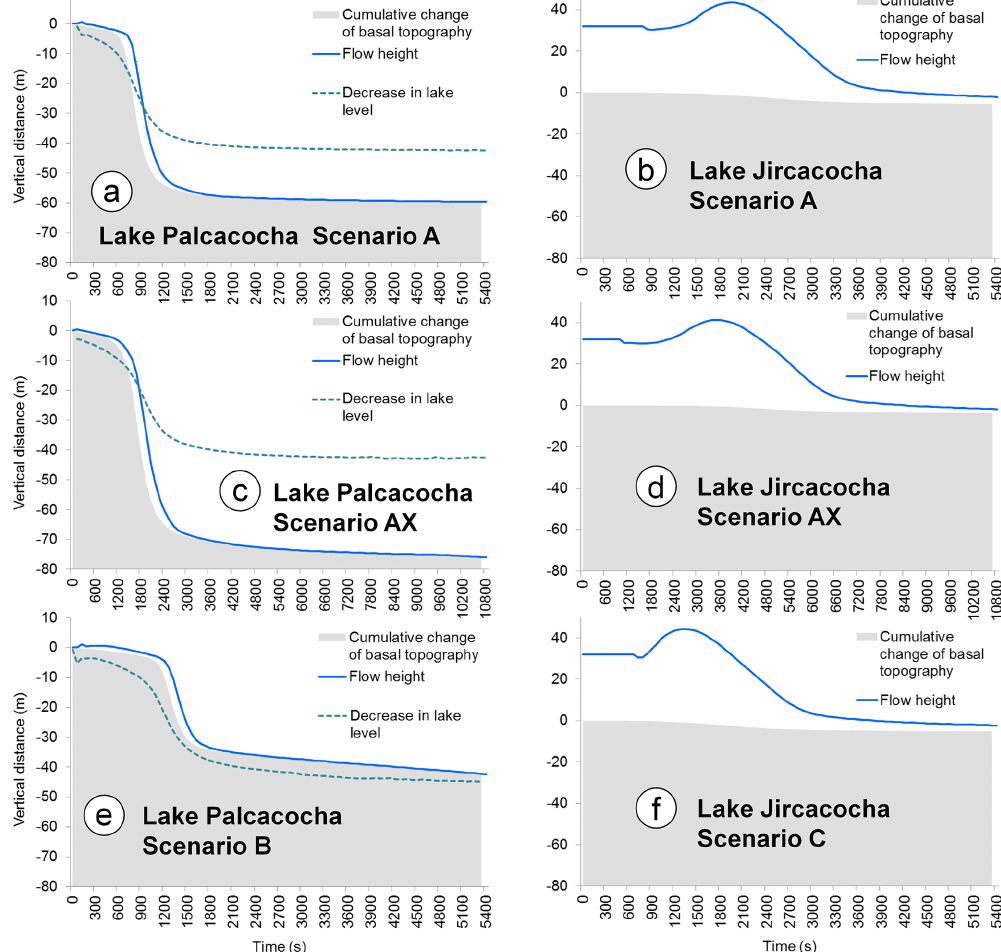
Figure 6. Evolution of flow height and basal topography at the outlets of Lake Palcacocha (reference point R1 in Fig. 4b), and Lake Jircacocha (reference point R2 in Fig. 4c). The reference points are placed in a way to best represent the evolution of the breach in the dam for Lake Palcacocha, and the evolution of the impact wave for Lake Jircacocha. Additionally, the evolution of the lake level is shown for Lake Palcacocha. Note that the result for Scenario B is only displayed for Lake Palcacocha (e) , whereas the result for Scenario C is only illustrated for Lake Jircacocha (f) . The vertical distance displayed on the y axis refers to the terrain height or the lake level at the start of the simulation, respectively, whereby the flow height is imposed onto the topography. In Scenario B, the initial impact wave at the dam of Lake Palcacocha is only poorly represented due to the low temporal resolution of the simulation, and due to blurring by numerical effects (e)